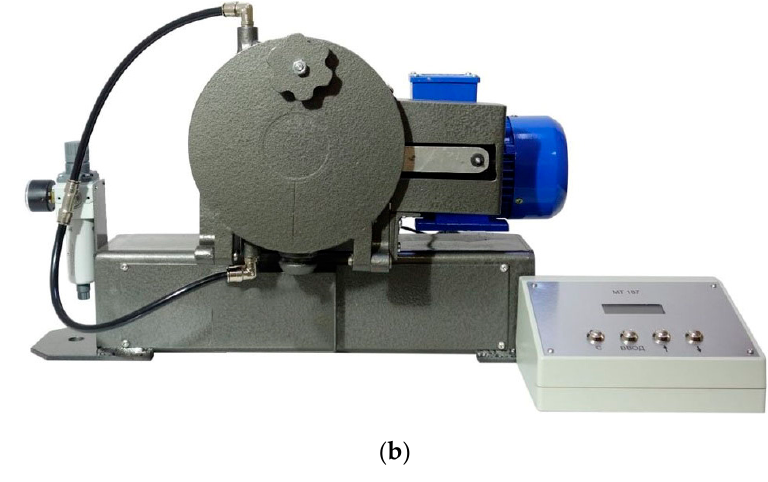
Figure 1. A scheme of the abrasive wear tests ( a ) and the “MI-2” abrasion testing machine ( b ). Weight loss was determined every 5 min during the total test duration of 20 min. The samples were weighed using the “Sartogosm LV 120-A” (Sartogosm LLC, Saint Peters- burg, Russia) with an accuracy of 0.1 mg. Russia) with an accuracy of 0.1